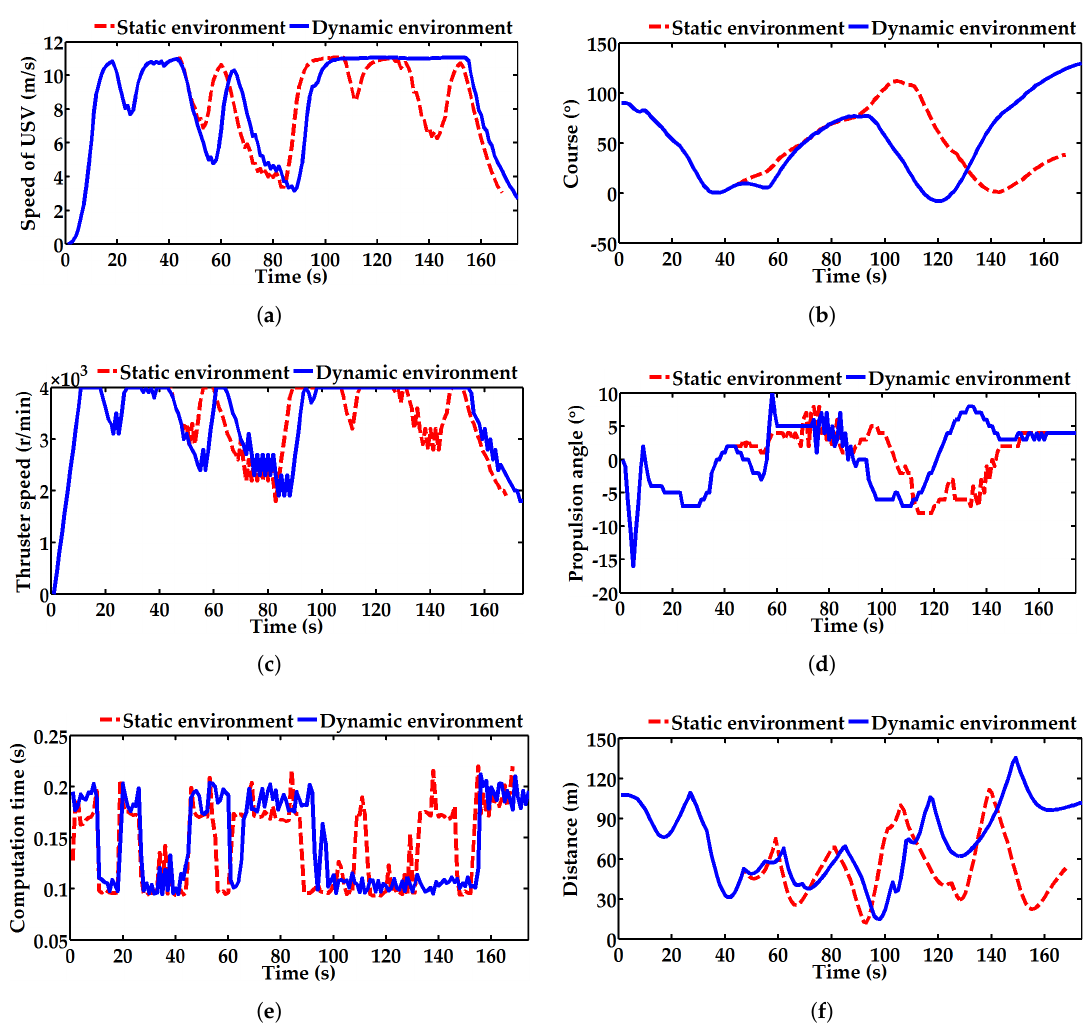
Figure 7. Evaluation results in the simulation environment. ( a ) Speed of the USV; ( b ) course of the USV; ( c ) thruster speed; ( d ) command propulsion angle; ( e ) computation time; ( f ) distance between obstacles and the